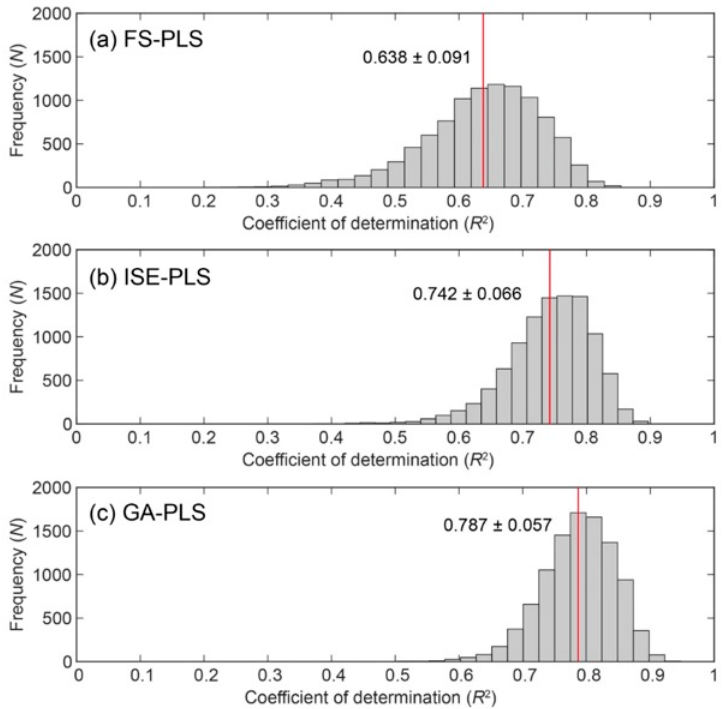
Figure 7. Comparisons of the frequency distributions of R 2 values in the test data ( n = 34) from ( a ) FS-PLS, ( b ) ISE-PLS and ( c ) GA-PLS using FDR, with mean (red line) ± standard deviation (SD) values.